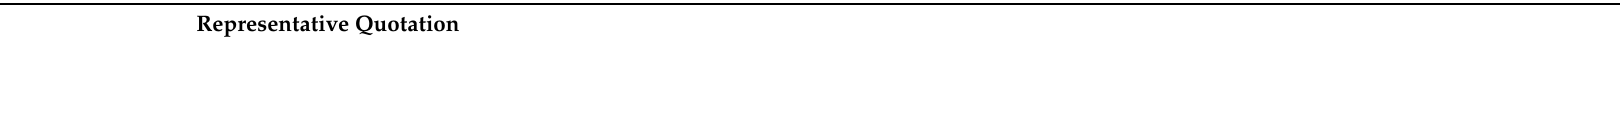
Table 3. Categories and subcategories with Representative Quotations of